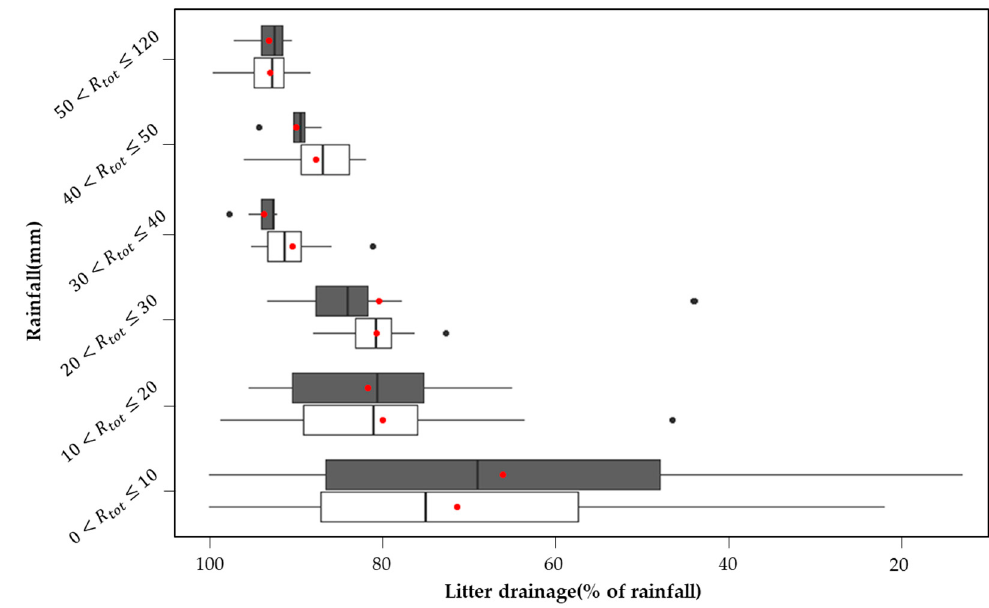
Figure 6. Variation in litter drainage with